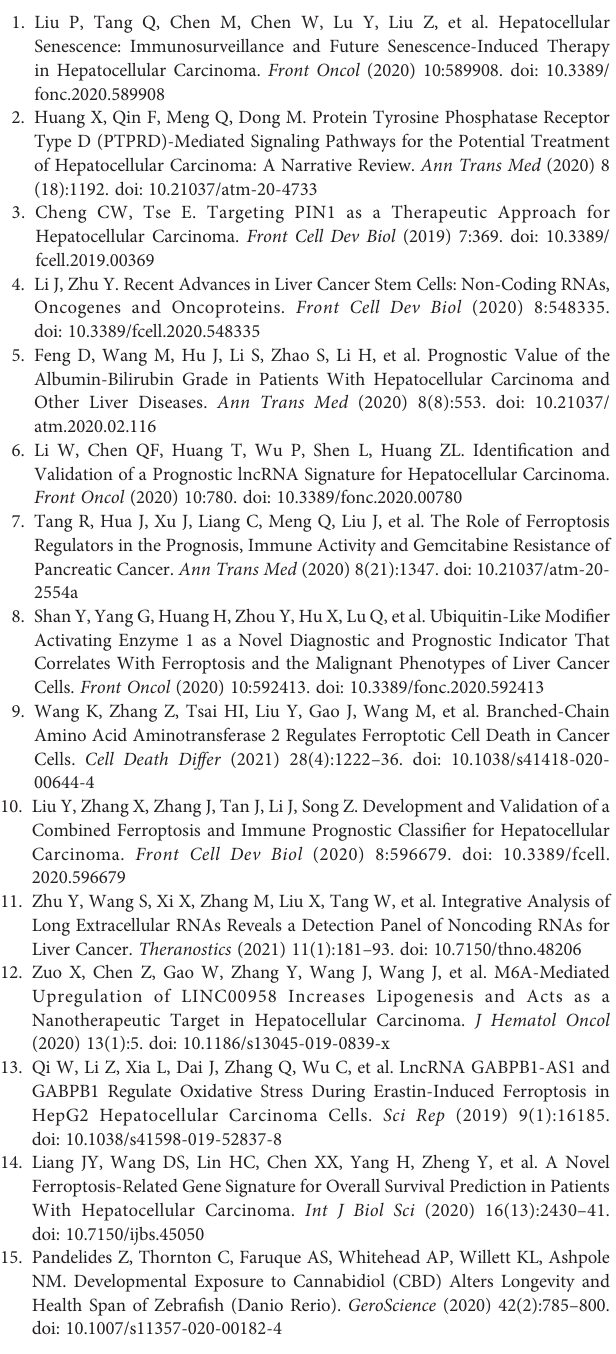
Supplementary Figure 3 | Prognostic value of ferroptosis-associated lncRNA signature in GSE40144. (A) Kaplan – Meier analysis was used to verify the prognostic values of novel lncRNA-based signature in hepatocellular carcinoma patients from GSE40144. (B) Time-dependent receiver operating characteristic curve for the survival prediction of the risk score model in the GSE40144 cohort. Supplementary Figure 4 | Spearman ’ s correlation on the association between the risk score of the signature and immune